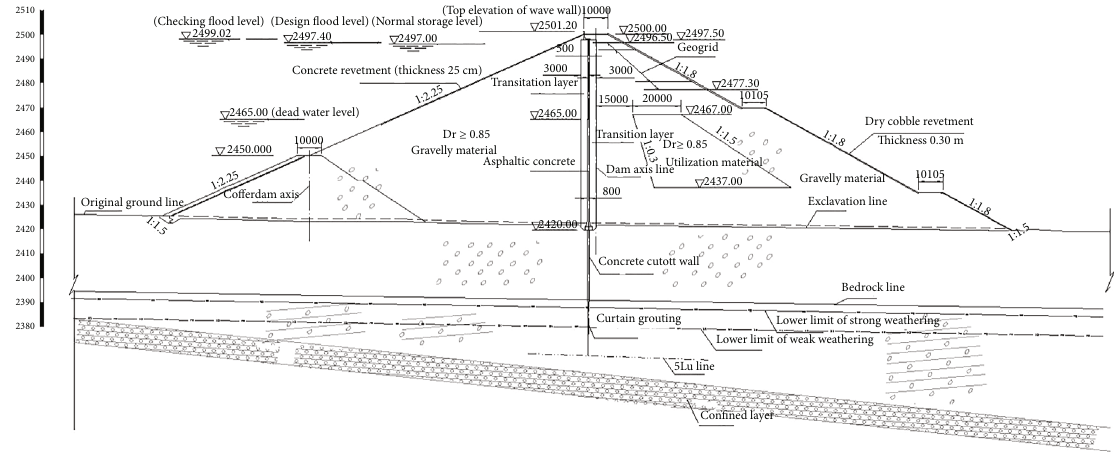
Figure 1: Typical pro fi le of a